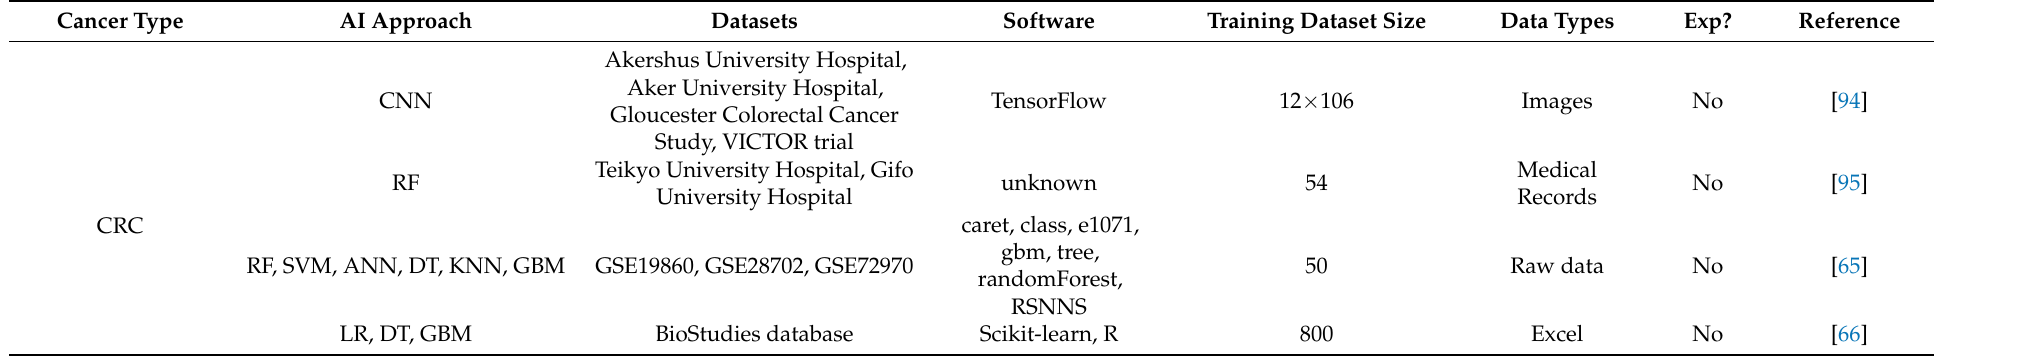
Table 5. List of works presented in Section 3.5 about the prediction of therapy outcome in cancer